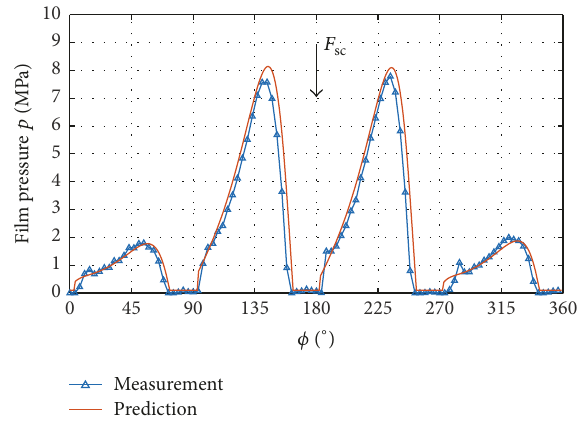
Figure 12: Measured and predicted pressure distribution (TPB120, ∘ C, and 𝑛 = 12000 min −1 , 𝑝 = 2.0 MPa, 𝑄 = 90 l/min, 𝑇 𝑞 sup = 50 𝑧 = 36 mm).